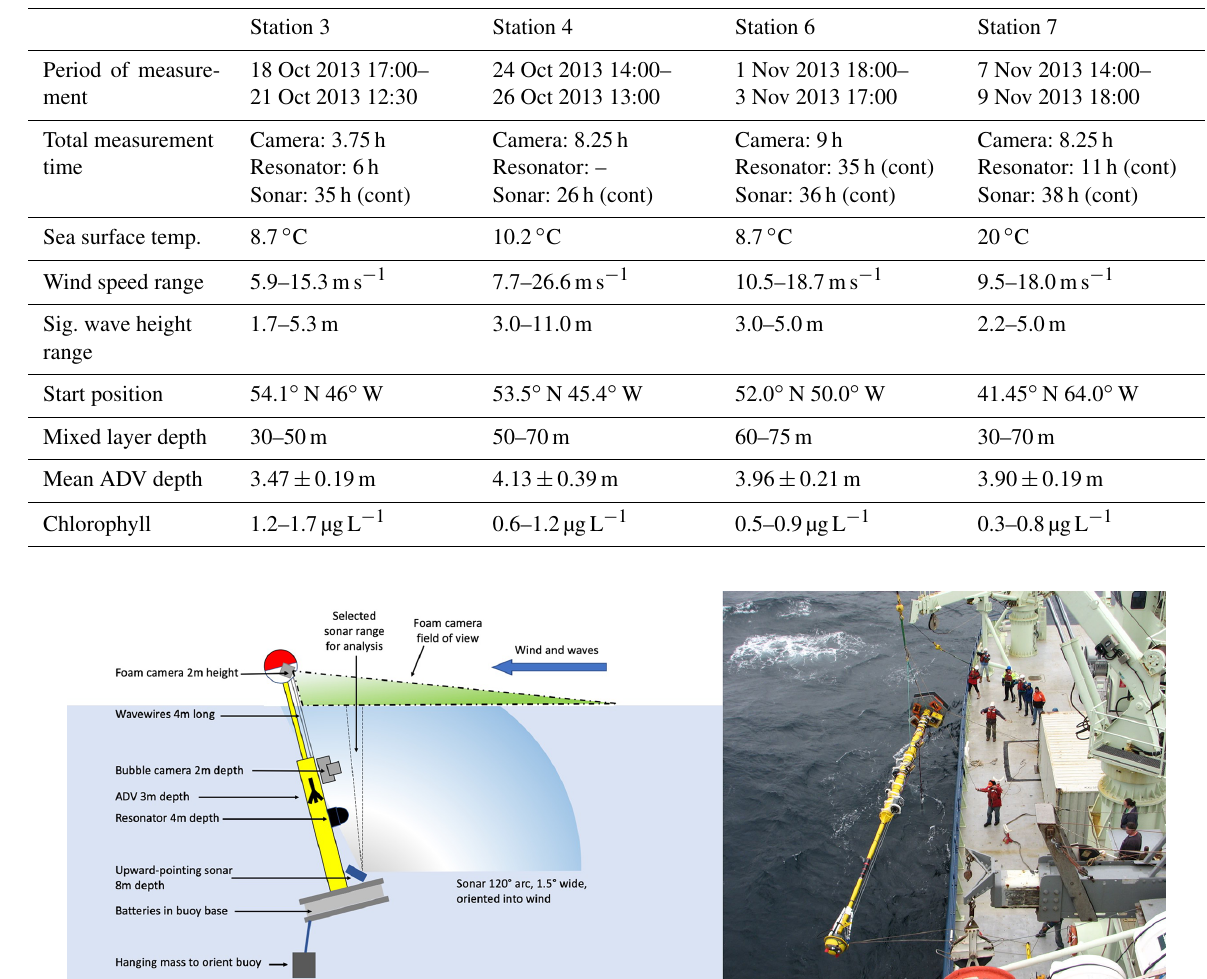
Figure 2. Schematic diagram of the 11m long spar buoy. The top 2m protruded above the water level, and the hanging mass caused a slight backwards lean which oriented the buoy into the wind. All instruments were positioned on the upwind side except the ADV, which was 90 ◦ further round the hull. The sonar data presented here are a subset of the full sonar arc, a 10 ◦ vertical section shown between the dotted lines and treated as a vertical profile through the water. (b) Buoy being